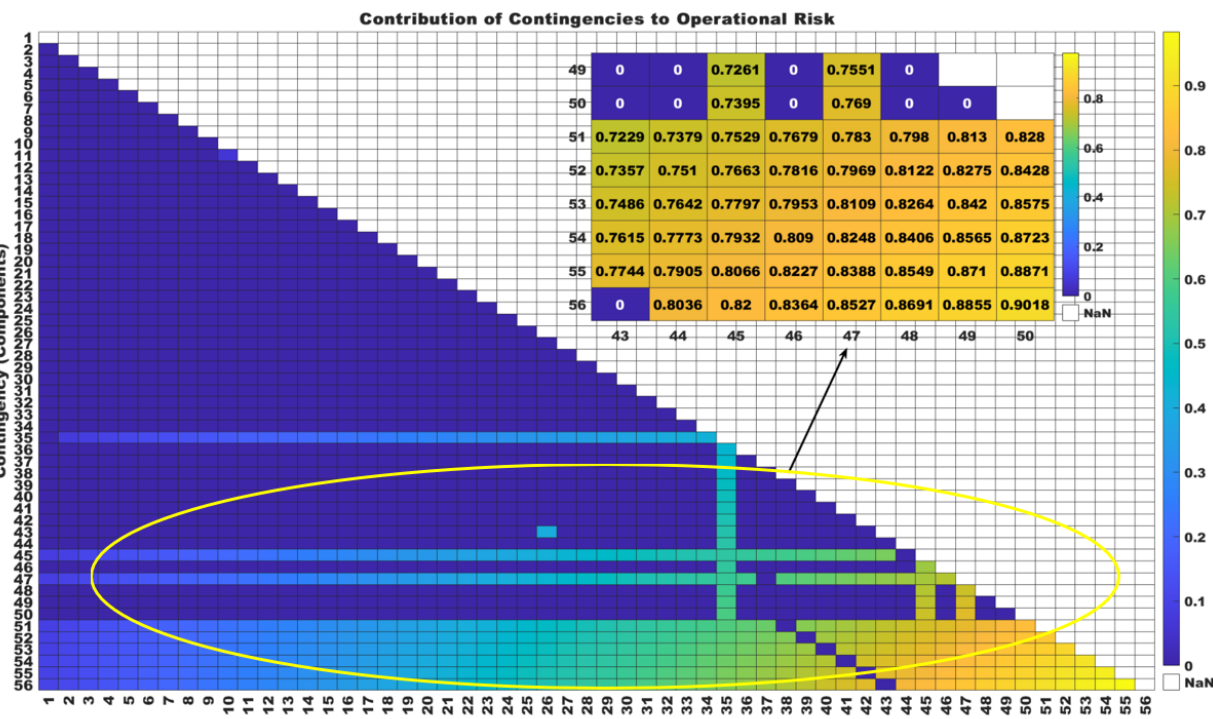
Figure 9. Contribution of contingencies towards ORSC (OS–1). The color scale indicates the contribution of each contingency (defined by Equation (8)), as quantified by the color bar on the right, in the relevant unit. The color scale is selected such that the lowest value is dark blue and the highest value is yellow.